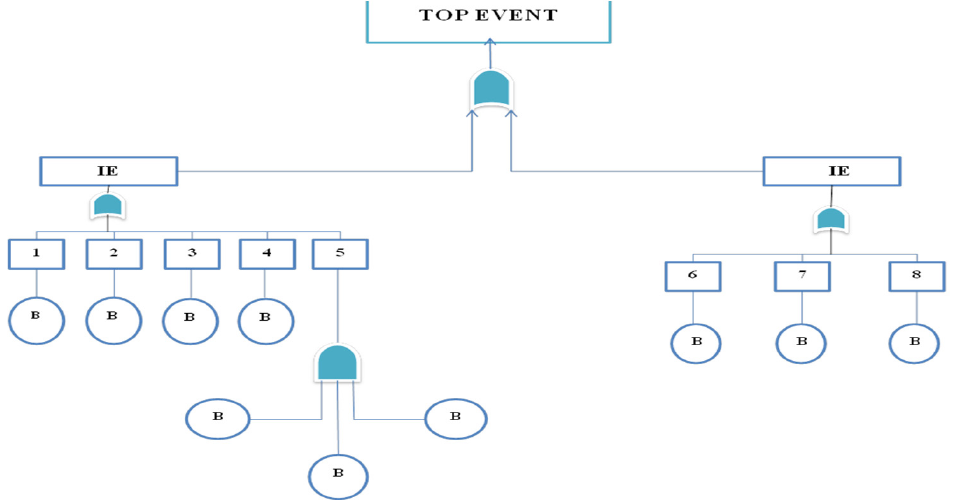
Figure 1. Fault tree